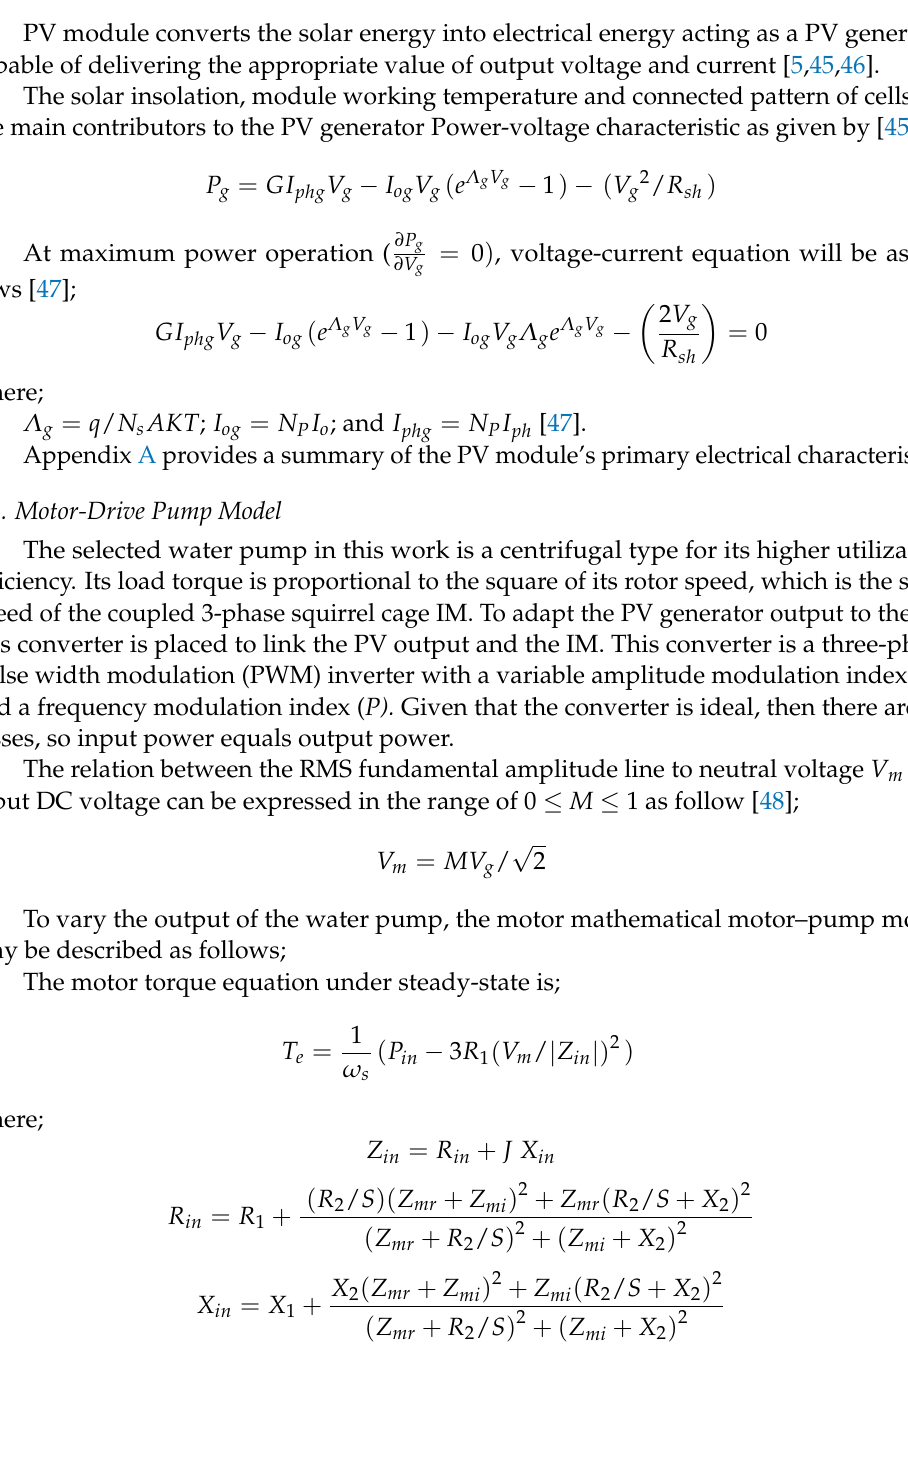
Figure 2. Solar cell equivalent circuit.